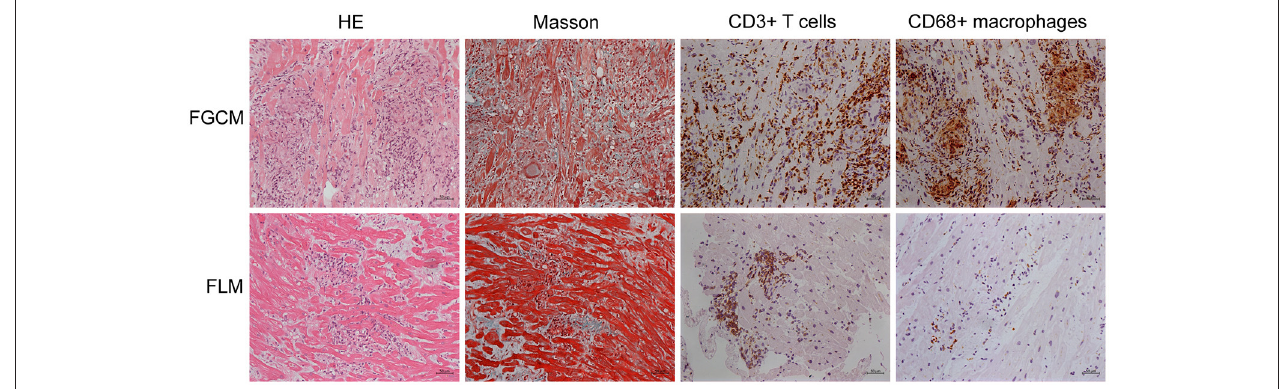
FIGURE 1 | Representative histopathology and immunopathology of patients with FGCM (upper line) and FLM (lower line). First column, hematoxylin and eosin (H&E); second column, Masson trichrome staining; third column, staining with anti-CD3 antibody; fourth column, staining with anti-CD68 antibody.